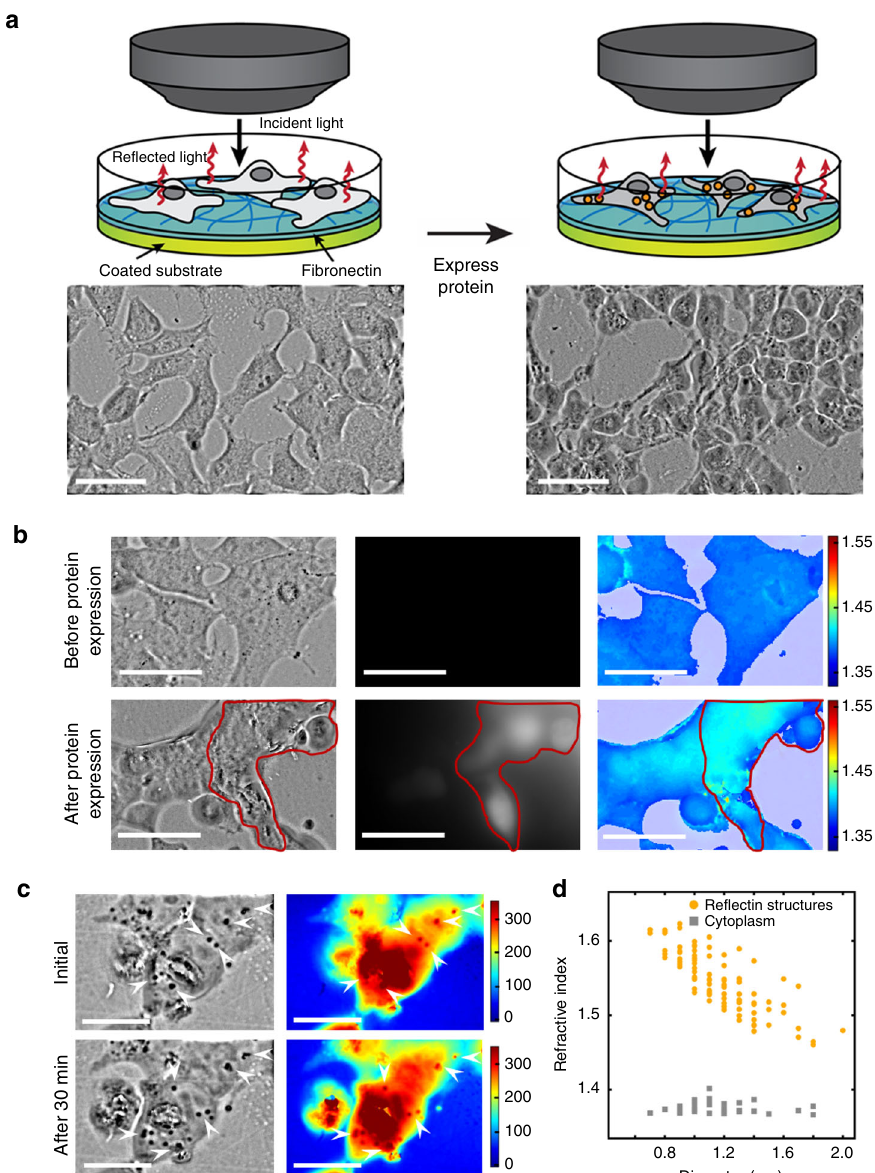
Fig. 3 Evaluation of the optical characteristics of engineered squid protein-producing human cells. a (Left) A schematic (top) and re fl ection-mode quantitative phase microscopy image (bottom) of recently transfected cells. The cells possess moderate phase differences with the underlying substrate. (Right) A schematic (top) and re fl ection-mode quantitative phase microscopy image (bottom) of transfected cells that express RfA1. The cells possess more pronounced phase differences with the underlying substrate. The scale bar is 15 µ m in both images. b (Top row) A re fl ection-mode quantitative phase microscopy image (left), fl uorescence microscopy image (middle), and refractive index map (right) obtained for recently transfected cells, which do not yet express RfA1 and RFP. The cells exhibit no fl uorescence and have a relatively low average refractive index. The scale bars are 15 µ m in the images. (Bottom row) A re fl ection-mode quantitative phase microscopy image (left), fl uorescence microscopy image (middle), and refractive index map (right) obtained for transfected cells, some of which express RfA1 and RFP. The cells that express the proteins (outlined in red) exhibit fl uorescence signals and have a higher average refractive index. The scale bars are 15 µ m in the images. c (Top row) A transmission-mode quantitative phase microscopy image (left) and corresponding optical pathlength map (right) obtained initially during the imaging of cells that express RfA1. The cells contain numerous RfA1-based structures with higher phases (dark black spots labeled with white arrows, left) and longer optical pathlengths (dark red spots labeled with white arrows, right) relative to their immediate surroundings. The scale bar is 10 µ m in both images. (Bottom row) A transmission-mode quantitative phase microscopy image (left) and corresponding optical pathlength map (right) obtained 30 min later during the imaging of cells that express RfA1. The cells contain numerous RfA1-based structures which have changed their positions but still feature higher phases (dark black spots labeled with white arrows, left) and longer optical pathlengths (dark red spots labeled with white arrows, right) relative to the immediate surroundings. The scale bars are 10 µ m in both images. d A plot of the calculated refractive index as a function of the diameter for readily-distinguished RfA1-based structures (orange dots) and for analogous cytoplasmic regions (gray dots) speci fi cally found near the peripheries of cells that express